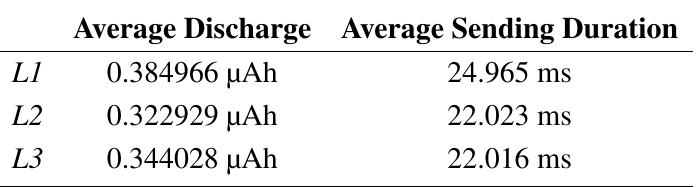
Table 1. Energy statistics L1–L3 for measurement 1.